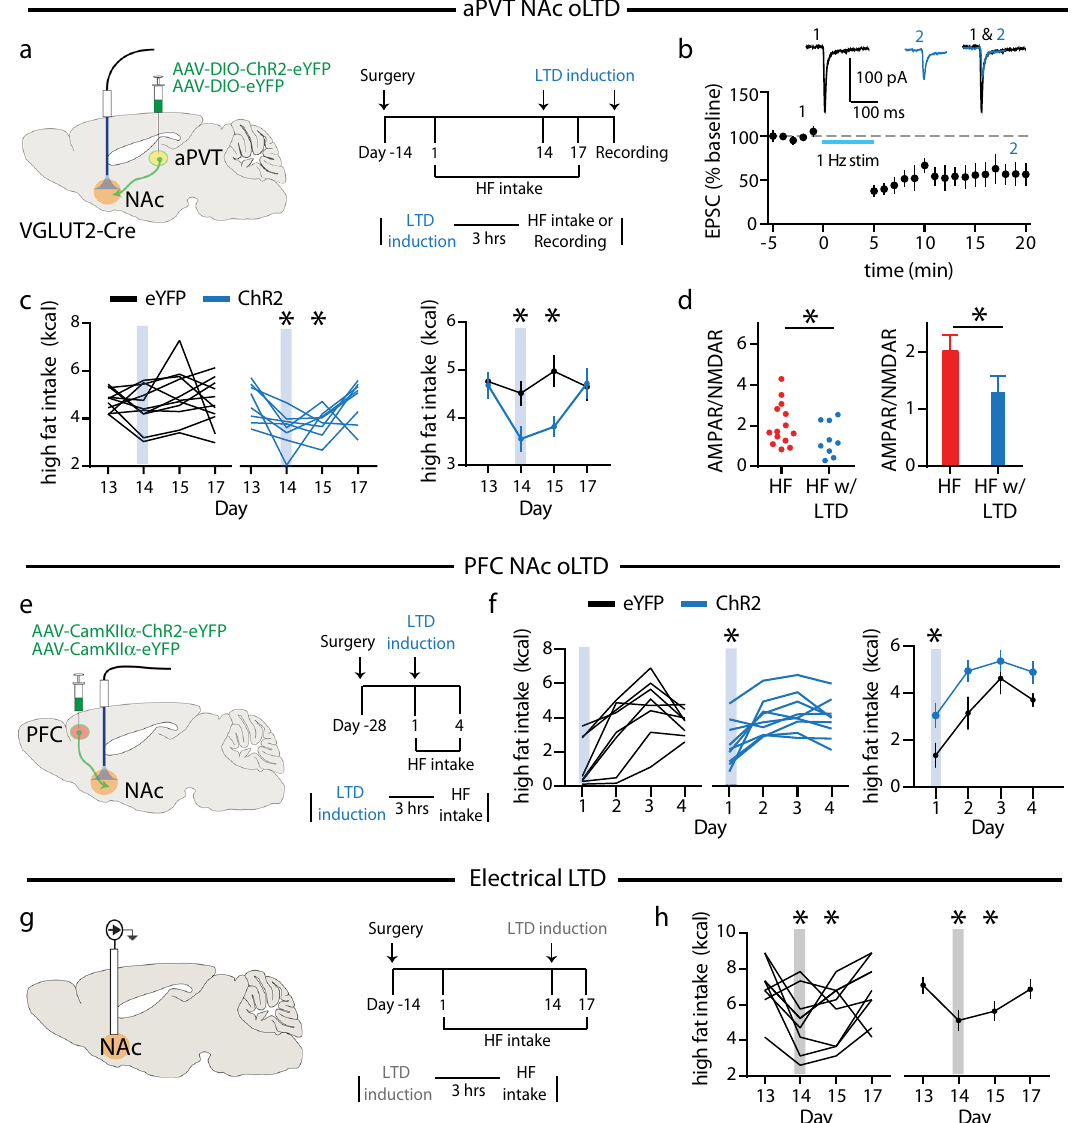
Fig. 6 Inducing LTD at excitatory inputs to NAc regulates high fat intake. a Schematic of viral infection and ferrule implant for aPVT input stimulation (left); experimental timeline (right). b Summary time course and representative traces of EPSC amplitude demonstrating optically induced depression of aPVT → D1 MSN synapses ( n = 4 cells). c Quanti fi cation of high fat intake following LTD induction ( F 3,51 = 3.07, P = 0.03, n = 11, 8 mice/group) in eYFP control (black) and ChR2 expressing (blue) mice. d Quanti fi cation of AMPAR/NMDAR ratio in D1 MSNs for aPVT inputs exposed to high fat without (red) and with (blue) LTD induction ( t = 1.75, P = 0.04, n = 14,9 cells/group). (Data for high fat group (red) in d are the same as those shown in Fig. 5c.) e Schematic of viral infection and ferrule implant for PFC input stimulation (left); experimental timeline (right). f Quanti fi cation of high fat intake following LTD induction ( F 1,15 = 4.57, P = 0.04, n = 8, 9 mice/group) in eYFP control (black) and ChR2 expressing (blue) mice. g Schematic of implant for electrical stimulation (left); experimental timeline (right). h Quanti fi cation of high fat intake following LTD induction ( F 3,24 = 4.59, P = 0.03, n = 9 mice). Gray bars signify electrical stimulation. Data are ±s.e.m. * P < 0.05, b Student ’ s t test two-tailed, c , f repeated measure two-way ANOVA with Sidak ’ s multiple comparison test, d Student ’ s t test one-tailed, h one-way ANOVA with Holm-Sidak multiple comparison test. Source data are provided as a Source Data fi